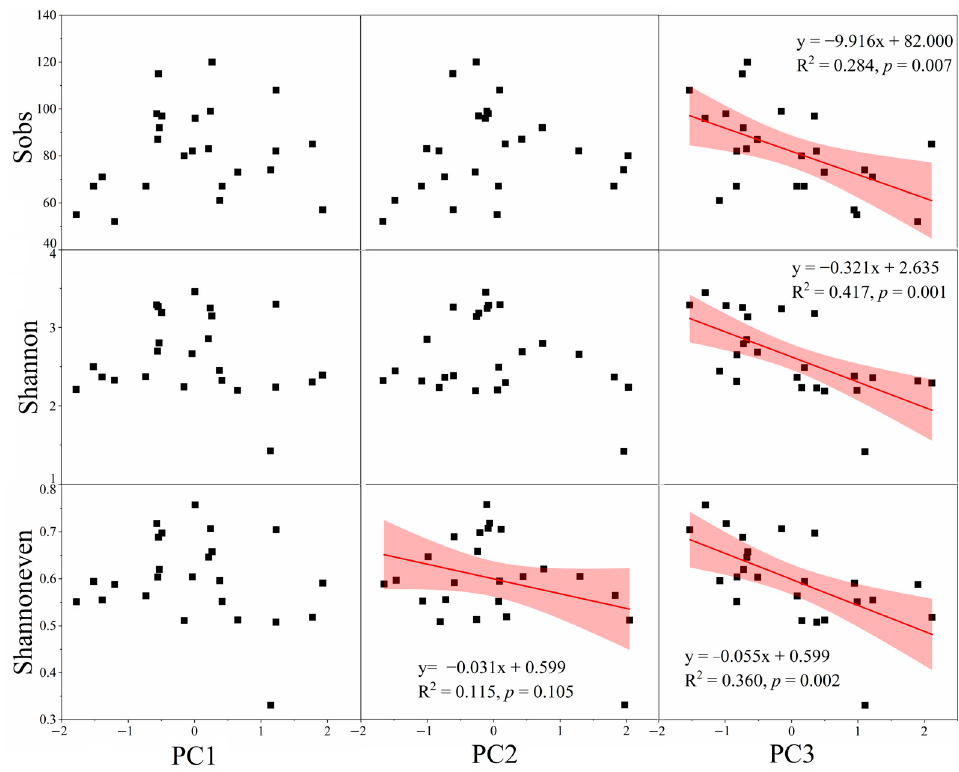
Figure 4. Relationship of the Sobs, Shannon, and Shannoneven indexes with soil principal compo- nents (PC) 1, PC2, and PC3 across samples from the Hg mining area. The red line is the fitting curve of the scatter plot, and the shaded area is the confidence region (95%) for the fitted line.